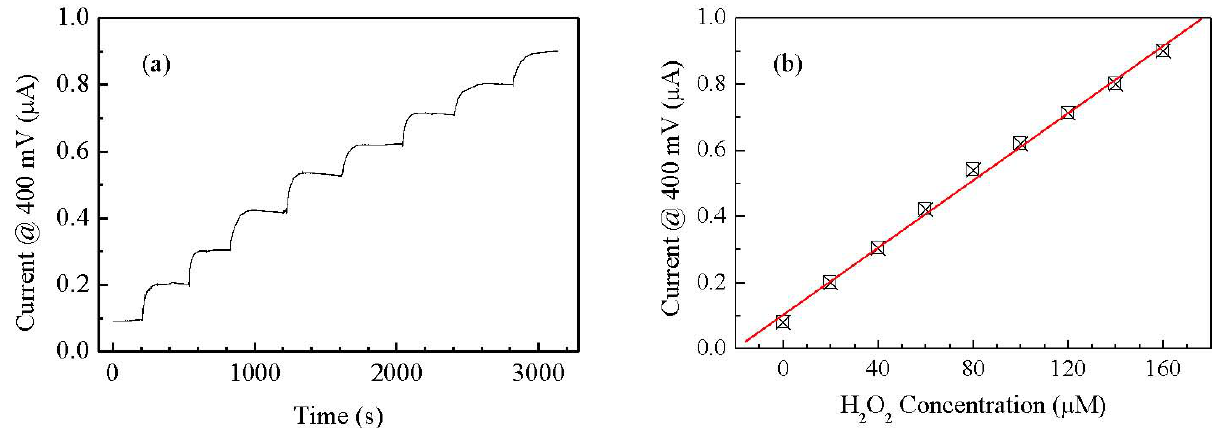
Figure 8. ( a ) Time evolution of the current measured at constant voltage on a gold/Nafion:polypyrrole/MWCNT cell in deionized water, in response to H injections in steps of 20 μ M; ( b ) plateau values of the current as function of the hydrogen peroxide concentration.